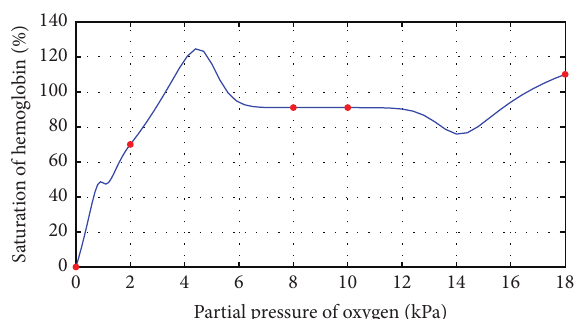
Figure 1: 𝐶 1 rational trigonometric cubic function with 𝛼 𝑖 = 1.0 , = 0.5, 𝛾 = 1.0, 𝛿 = 2.0 𝛽 𝑖 𝑖 𝑖